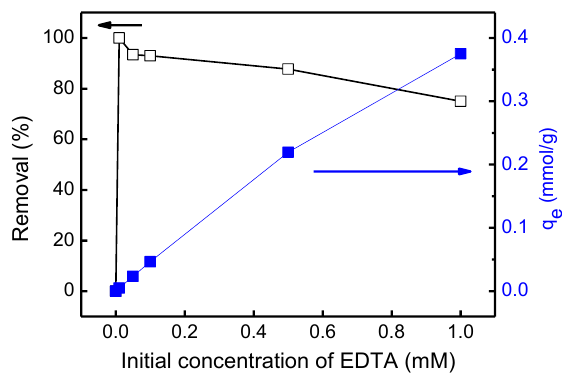
Figure 7. Changes in ( a ) removal efficiency of EDTA and ( b ) adsorption capacity of AERs in EDTA/Cs (1:1) with various amounts of AERs. [EDTA] = 0.1, 0.25, and 0.5 mM; pH = 7; adsorption time = 5 h.